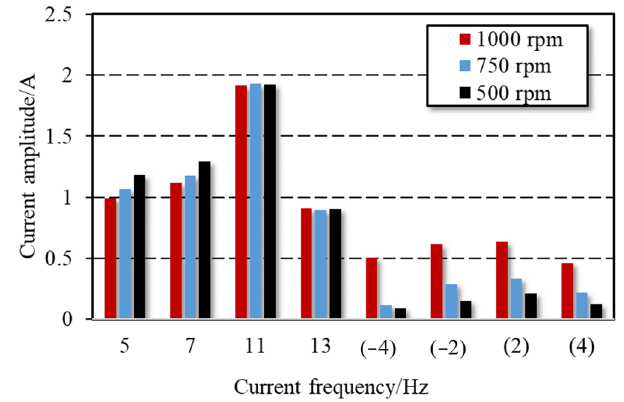
Figure 14. Comparison of main current harmonic amplitude.